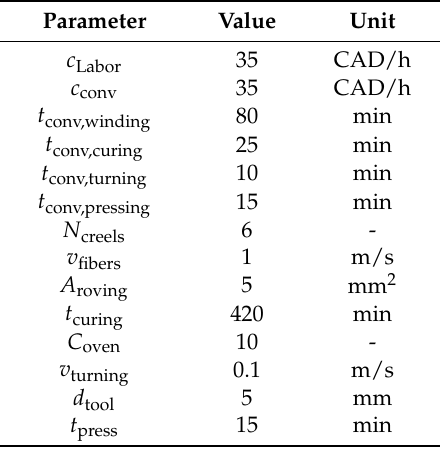
Table 4. Applied machine